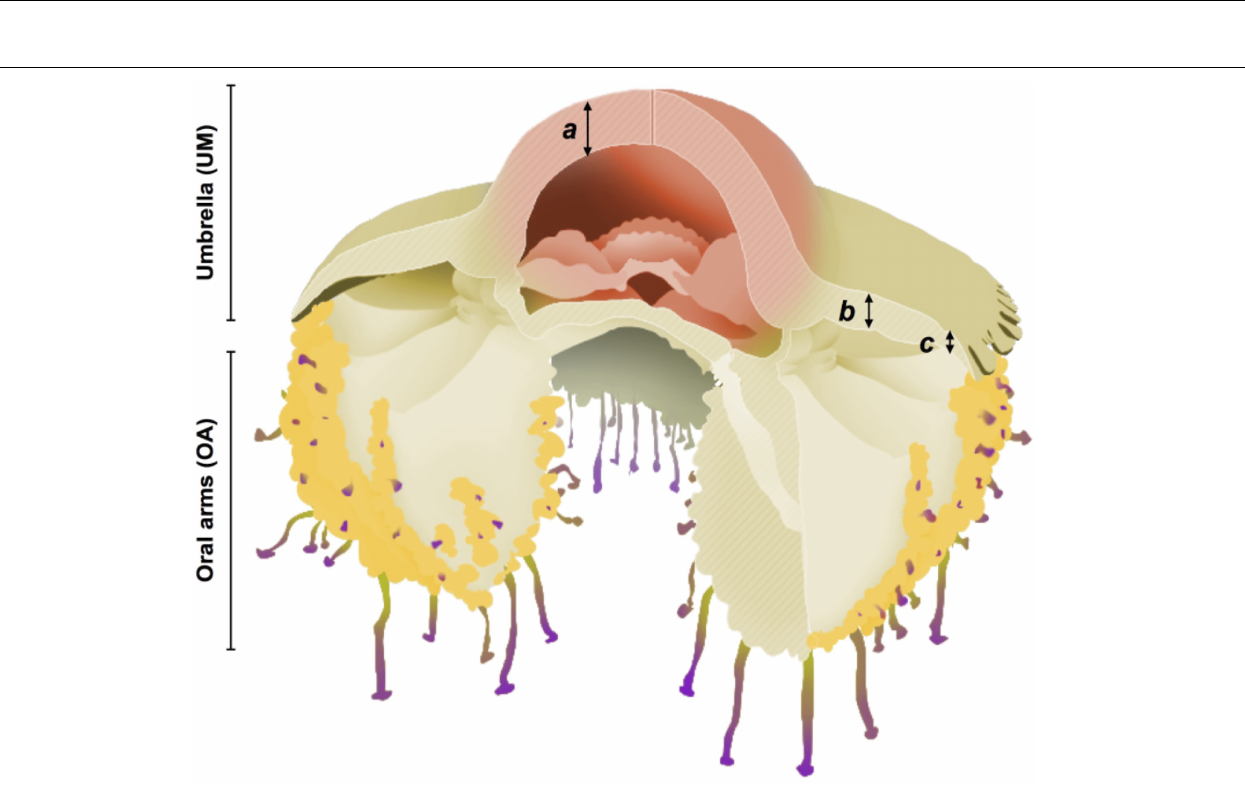
FIGURE 2 | Scheme of Cotylorhiza tuberculata . Umbrella (UM) and oral arms (OA) sections. Bell tissue sections used for absorbance analyses: (a) Central dome, (b) clear section, (c) marginal lappets. Modified and digitalized from Kikinger (1992) by A. Chover Navarro.